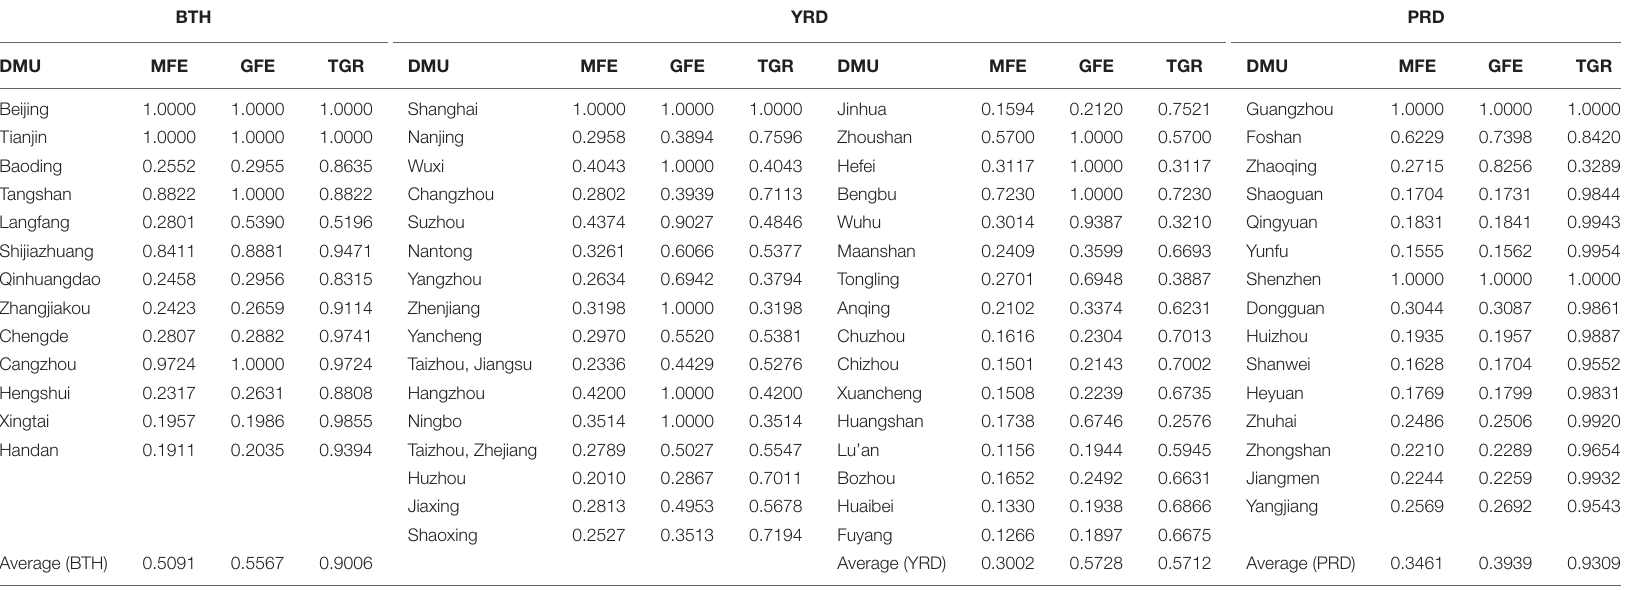
TABLE 5 | MetaFrontier and Group Frontier Efficiency